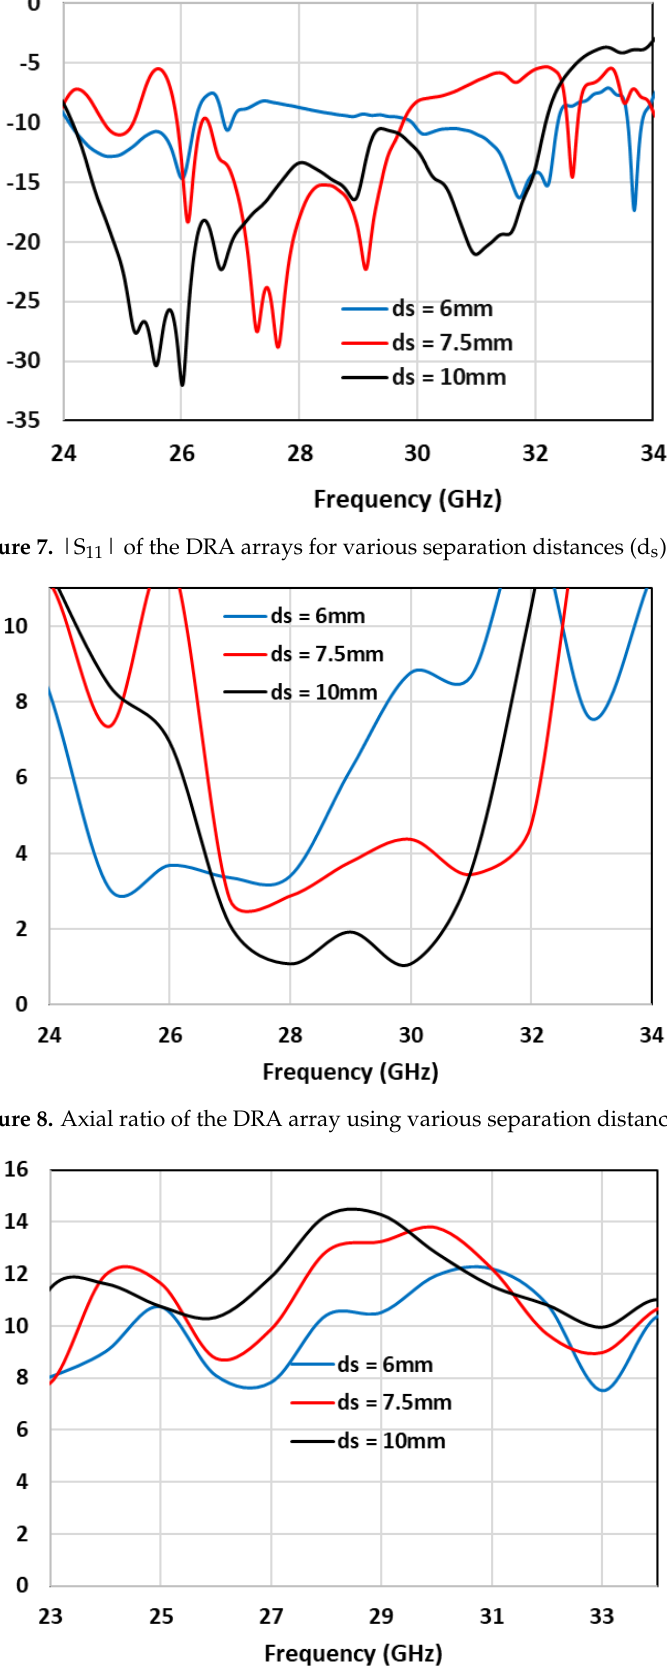
Figure 9. Gain of the DRA array using various separation distances (d s ) between the